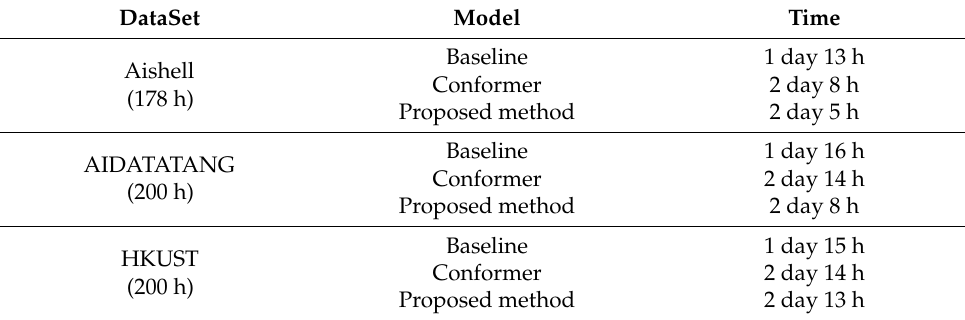
Table 3. Comparison of experiments for training